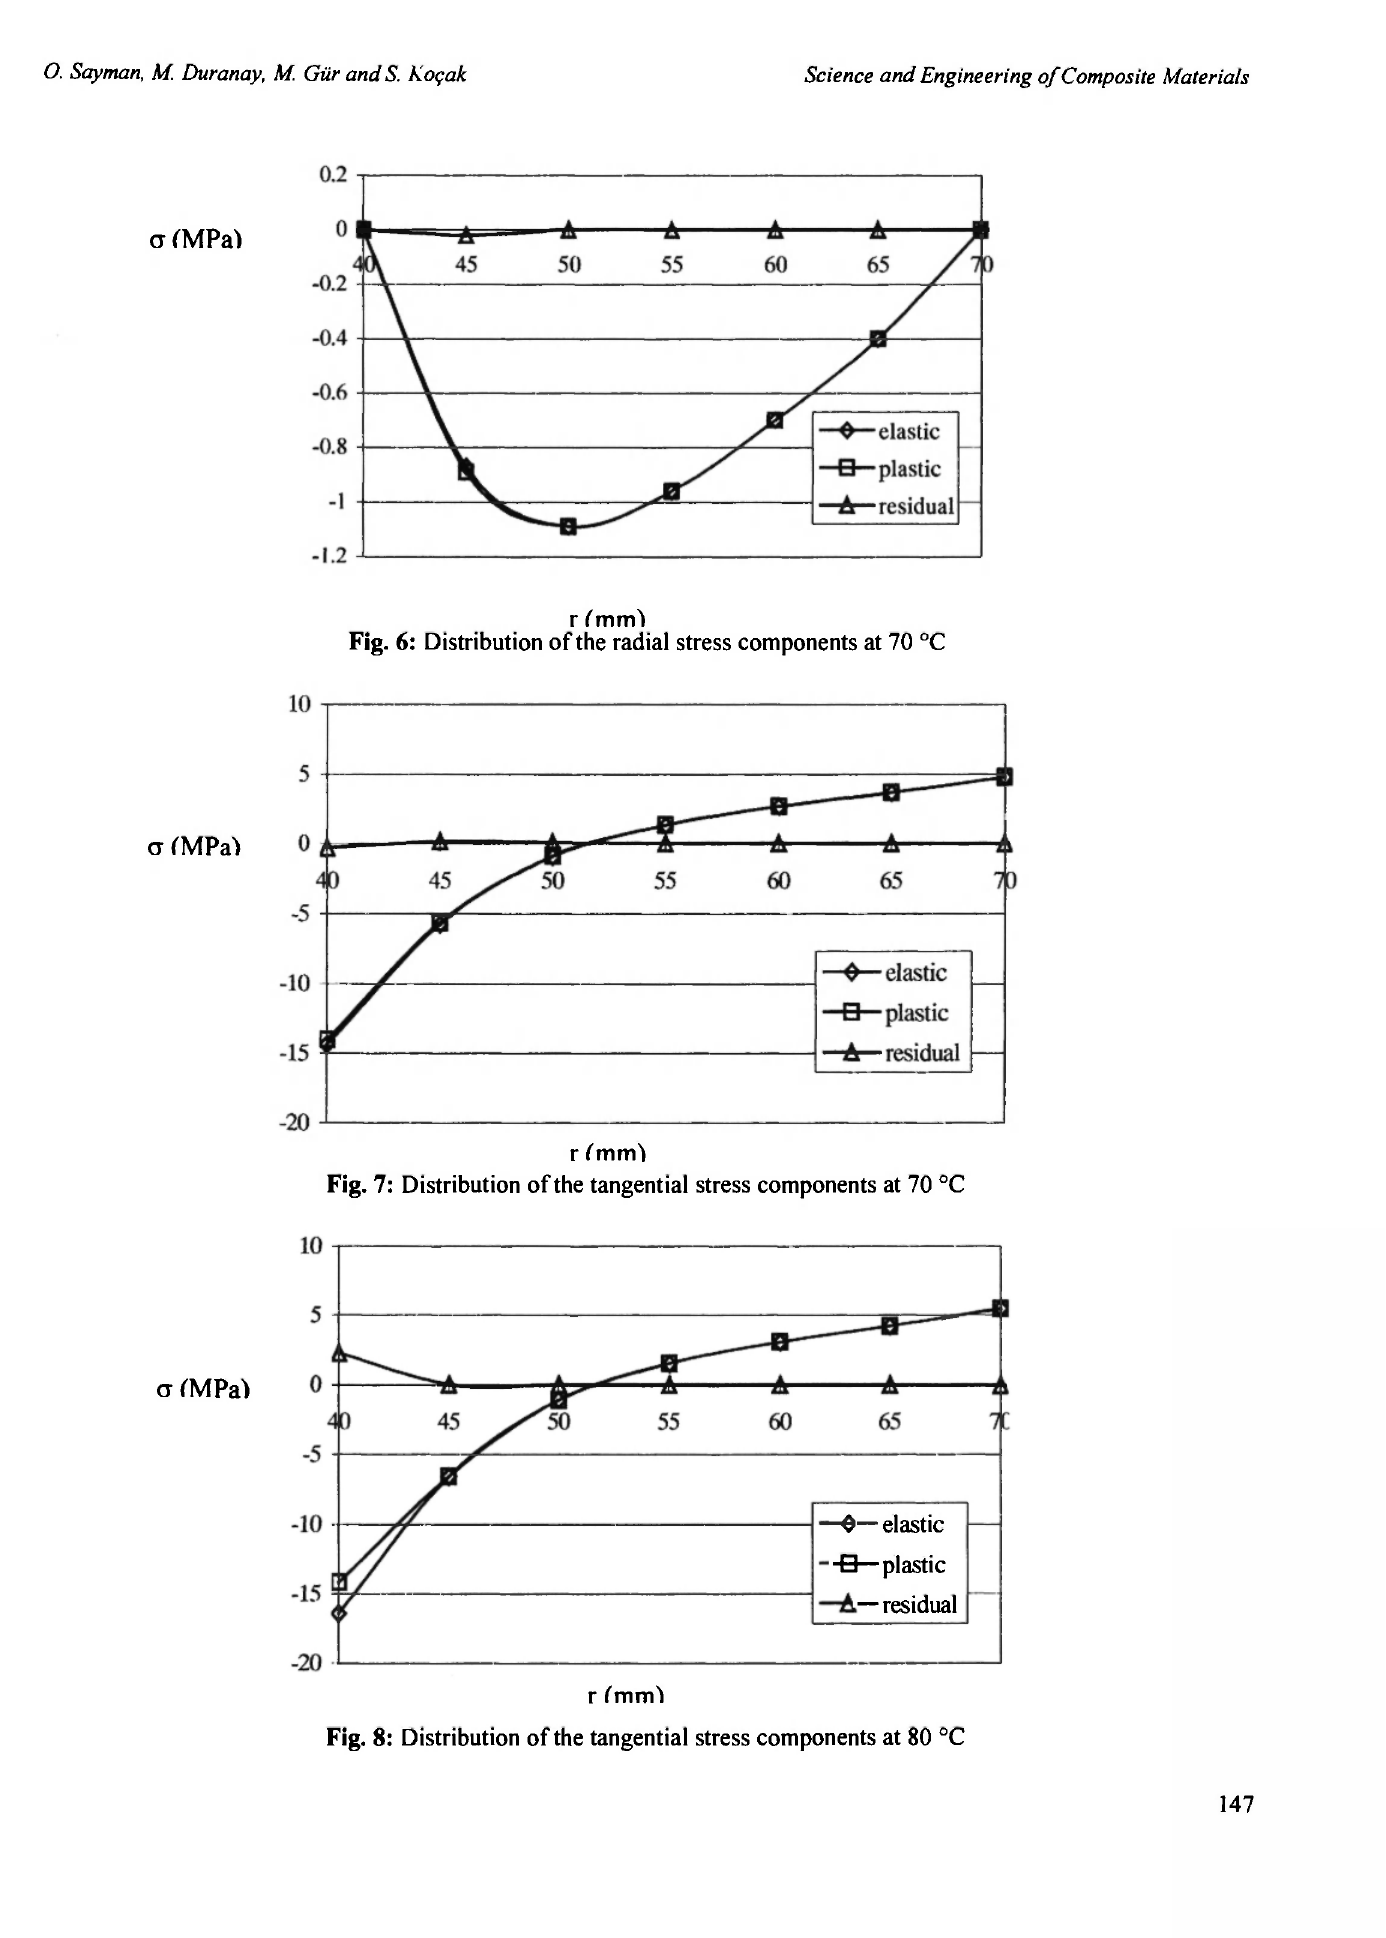
Fig. 8: Distribution of the tangential stress components at 80